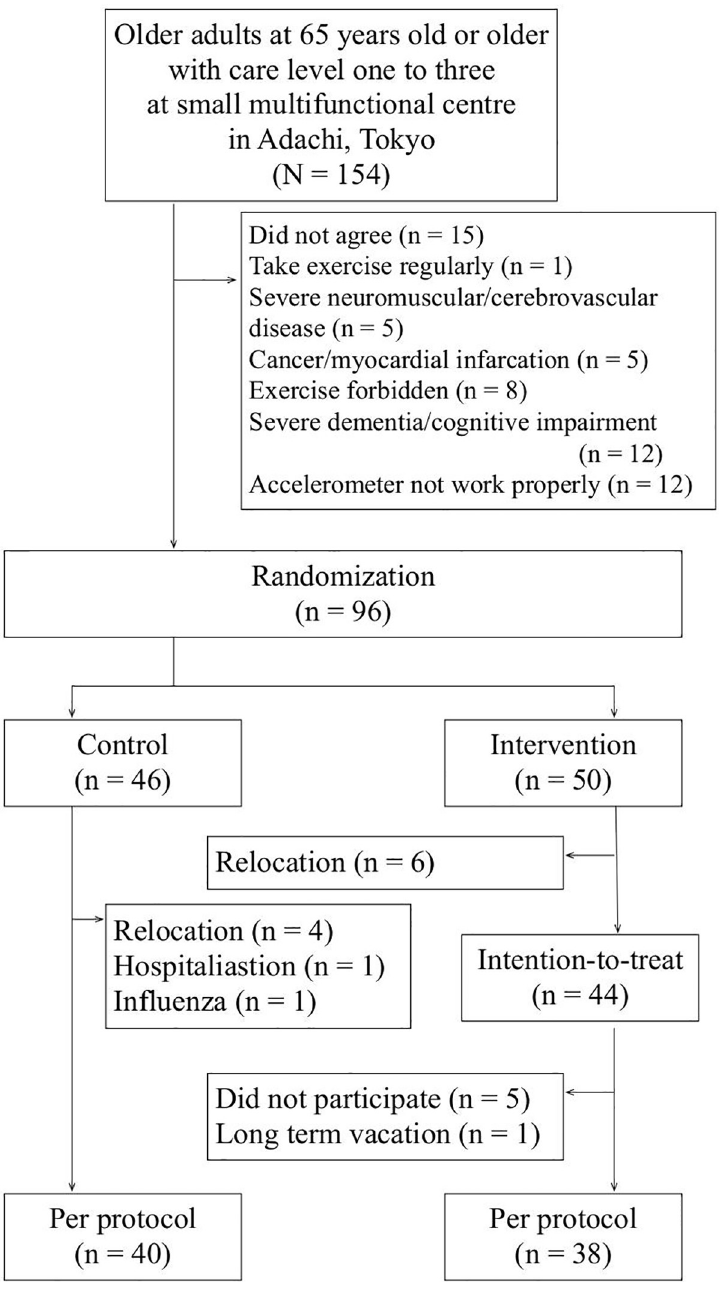
Fig 1. Flowchart of the